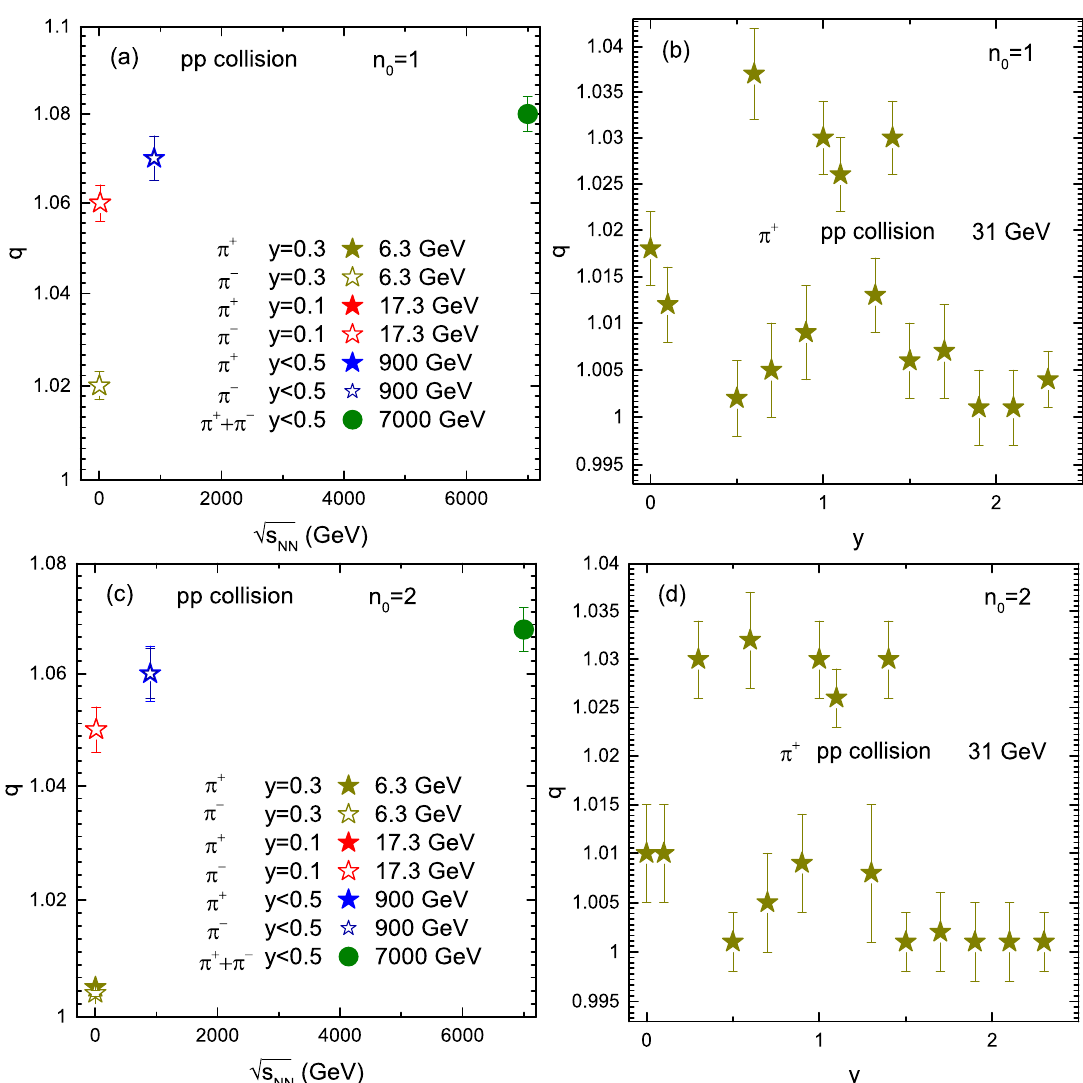
Figure 5. Dependence of the parameter q on collision energy as well as rapidity at 31 GeV. Panels ( a , c ) show the dependence of q on collision energy by using the flow profile n 0 = 1 and 2, respectively, in the TBW model, while panels ( b , d ) show its dependence on rapidity at 31 GeV. The multiplicity parameter N 0 is presented in Figure 6. Panels (a) and (c)